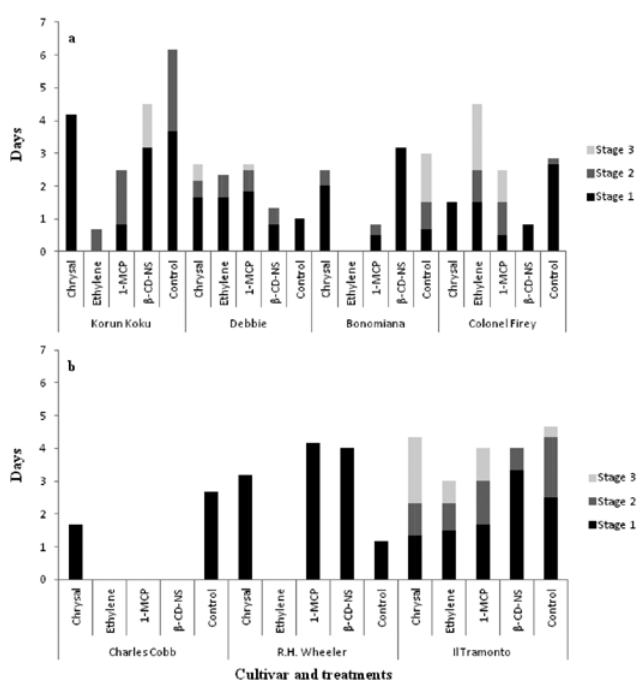
Fig. 2 - Variation in flower opening stages (stage 1 = initial opening, stage 2 = half opening, and stage 3 = full opening) of the studied Camellia japonica cultivar according to five treatments and two supply chains (a. Long, b. Short).